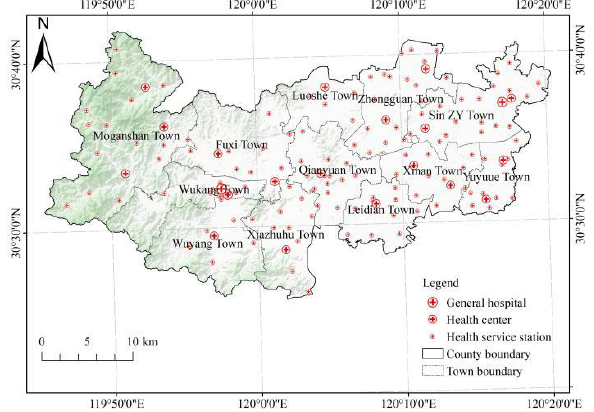
Figure 1. Spatial distribution of hospitals or health institution in Deqing